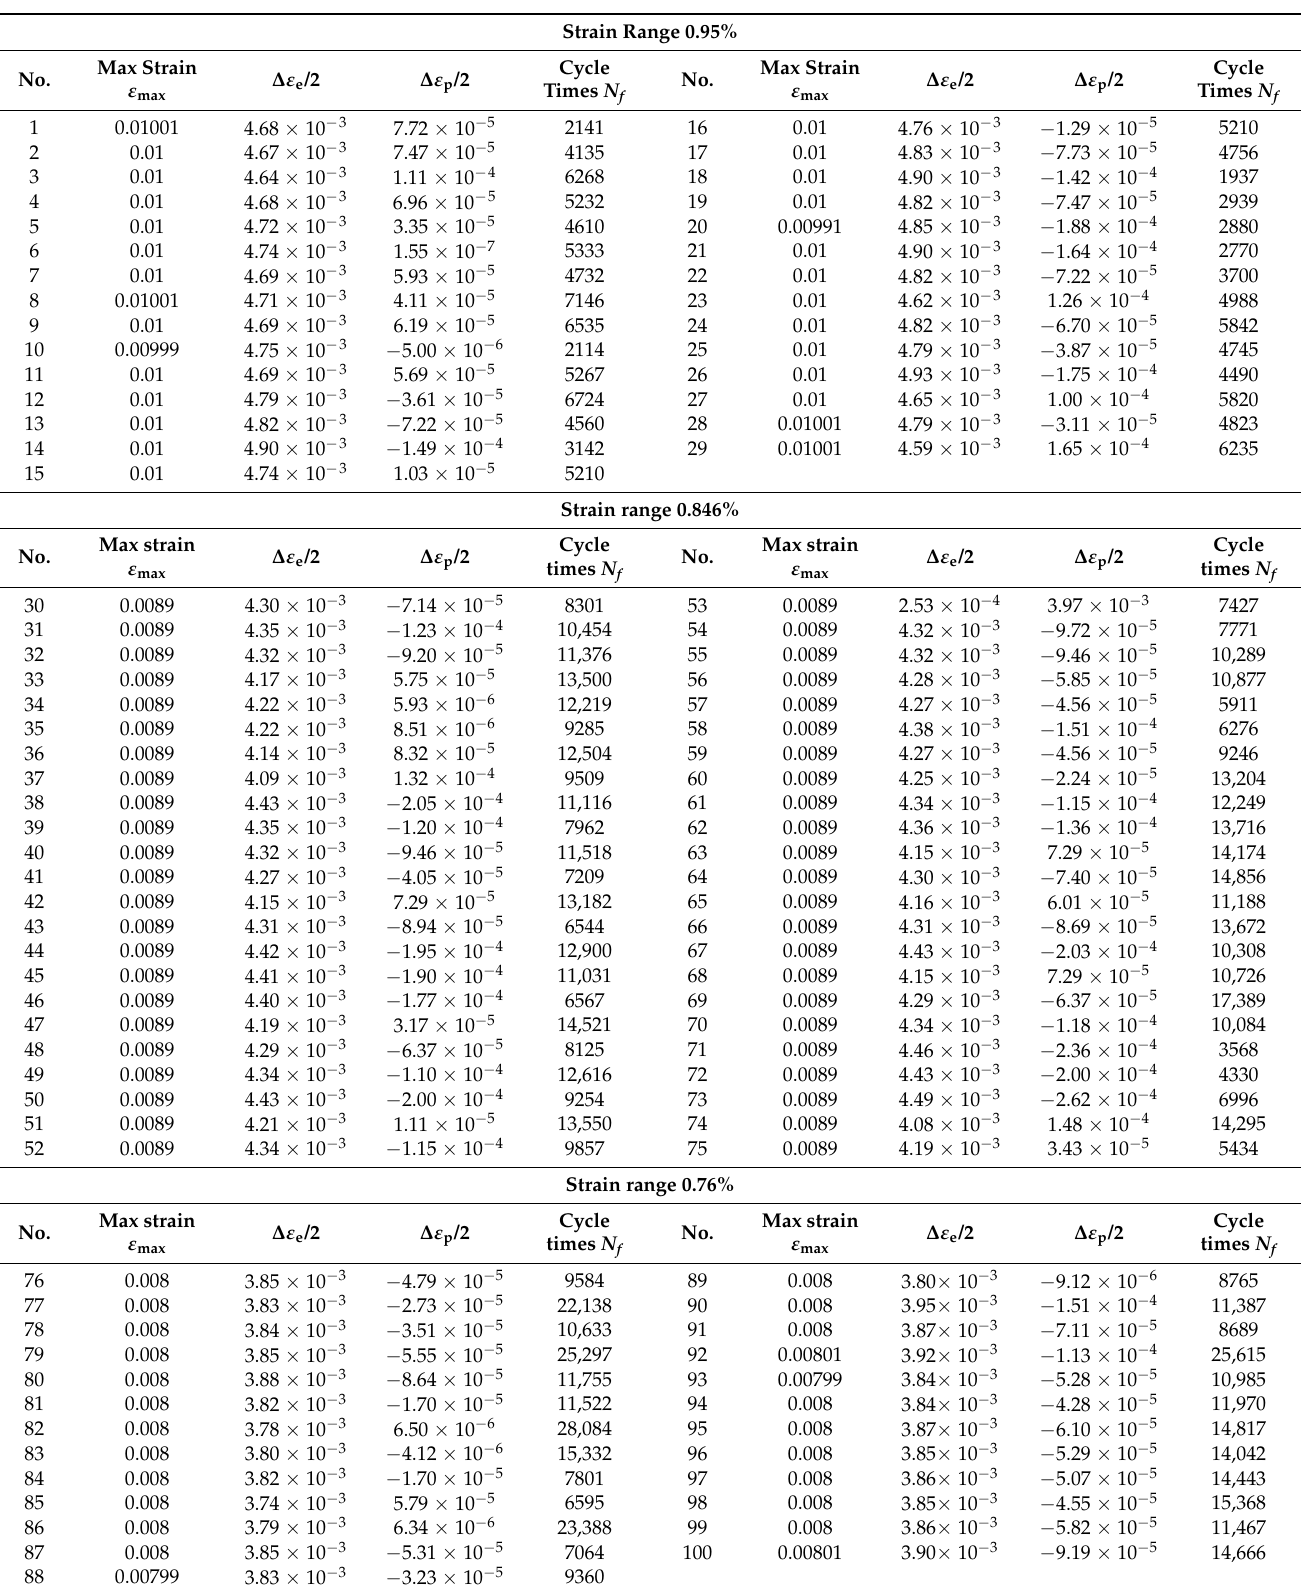
Table A1. Experimental strain amplitude data at T = 530 ◦ C, R =